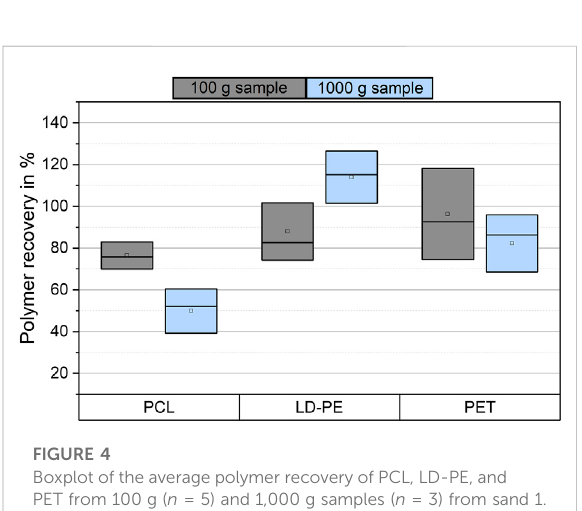
FIGURE 3 Boxplot of recovery rates of PCL, LD-PE, and PET microplastic particles from different particulate matrices ( n = 5). RecoveryratesweredeterminedbyDSCmeasurements.TheSDof the data is shown as the width of the boxes.